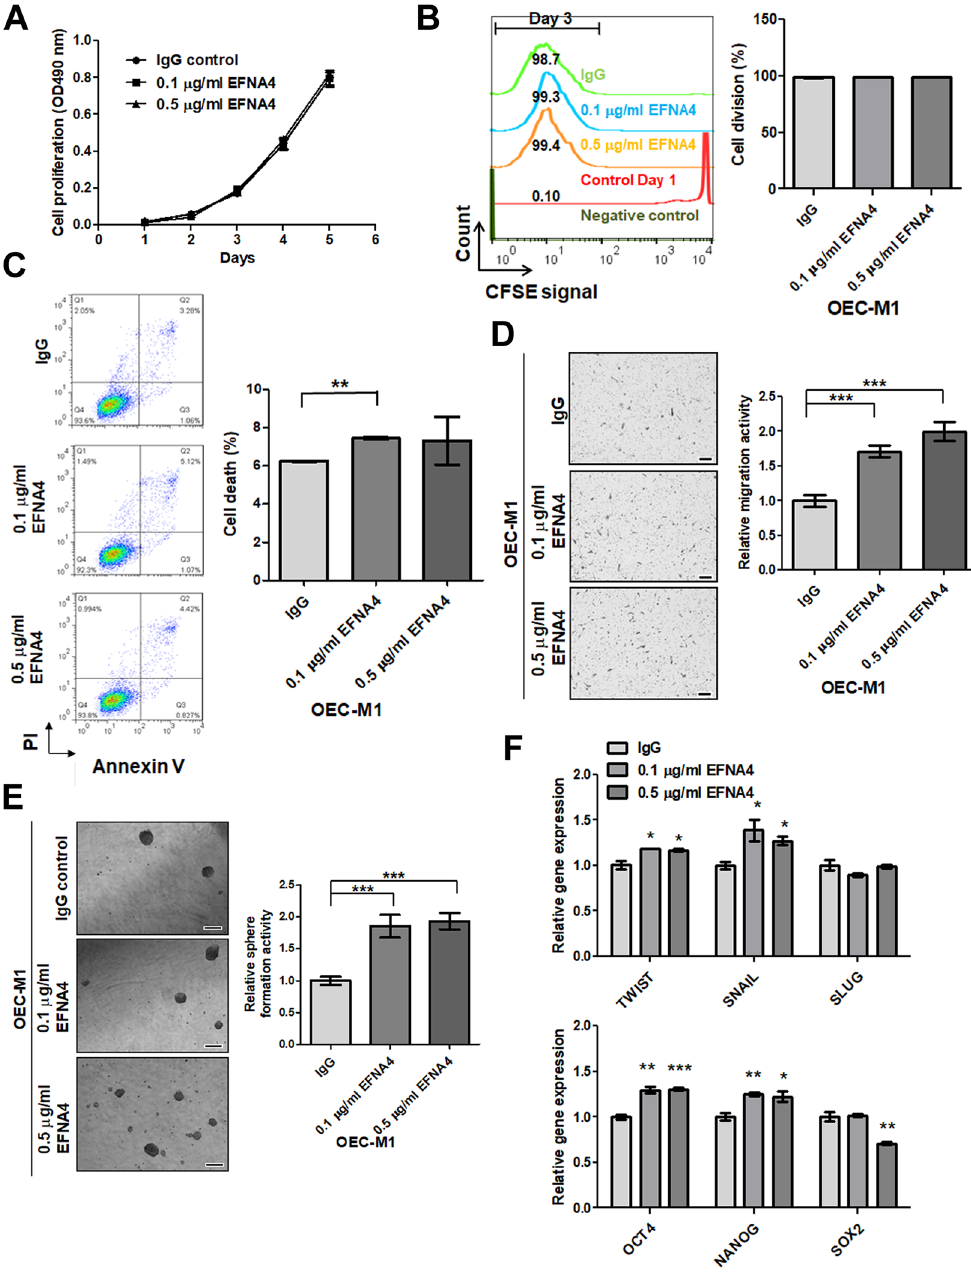
Figure 3. Exogenous EFNA4-Fc enhanced cell migration and sphere formation of OEC-M1 cells. ( A ) Representative growth curves of OEC-M1 cells treated with 0.1 or 0.5 μg/ml EFNA4-Fc (n = 4) or 0.5 μg/ml IgG control (n = 4) based on MTS assay data. ( B ) Left: Representative CFSE cell division assay data from OEC-M1 cells treated with 0.1 or 0.5 μg/ml EFNA4-Fc (n = 2) or 0.5 μg/ml IgG control (n = 2). The interval bar indicates cell division signal on day 3. Right: The percentage of the cell population within the interval bar limits. ( C ) Left: Representative cell death analysis via PI/Annexin V double staining of OEC-M1 cells treated with 0.1 or 0.5 μg/ml EFNA4-Fc (n = 2) or 0.5 μg/ml IgG control (n = 2). Right: The percentage of cell death, including quadrants Q1, Q2, and Q3. ( D ) Left: Representative images of migrated cells. Scale bars, 100 μm. Right: Relative migration activity was determined by normalizing the mean number of migrated cells per field of EFNA4-Fc treated cells (n = 10) to that of the IgG-treated cells (n = 10). ( E ) Left: Representative images of tumorspheres. Scale bars, 100 μm. Right: Sphere formation in OEC-M1 cells treated with 0.1 or 0.5 μg/ml EFNA4-Fc or 0.5 μg/ml IgG control in sphere culture. Relative sphere formation activity in EFNA4-treated cells (n = 2) was determined by normalizing the mean number of spheres per well to that of the IgG-treated cells (n = 2). ( F ) Relative levels of TWIST , SNAIL , SLUG , OCT4 , NANOG , and SOX2 mRNA in OEC-M1 cells treated with 0.1 or 0.5 μg/ml EFNA4-Fc or 0.5 μg/ml IgG as determined by qRT-PCR. The amplifications were first normalized to β-actin (internal control). The relative mRNA expression in EFNA4-treated OEC-M1 cells (n = 3) was then normalized to that in IgG-treated cells (n = 3). Bars represent SE. * p < 0.05; ** p < 0.01; *** p <